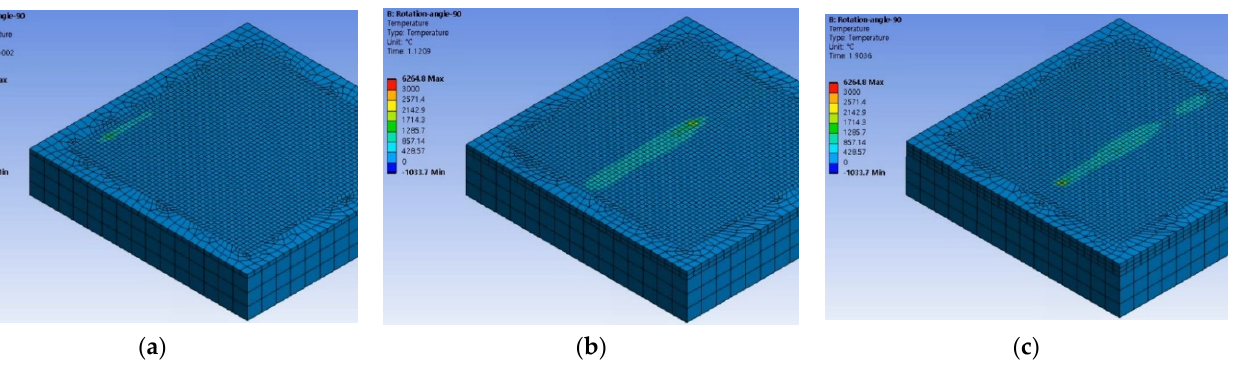
Figure 4. Laser heat input simulation result: ( a ) 68 ms—early stage of first layer heat input; ( b ) 1121 ms—second layer heat input; ( c ) 1904 ms—third layer heat input.